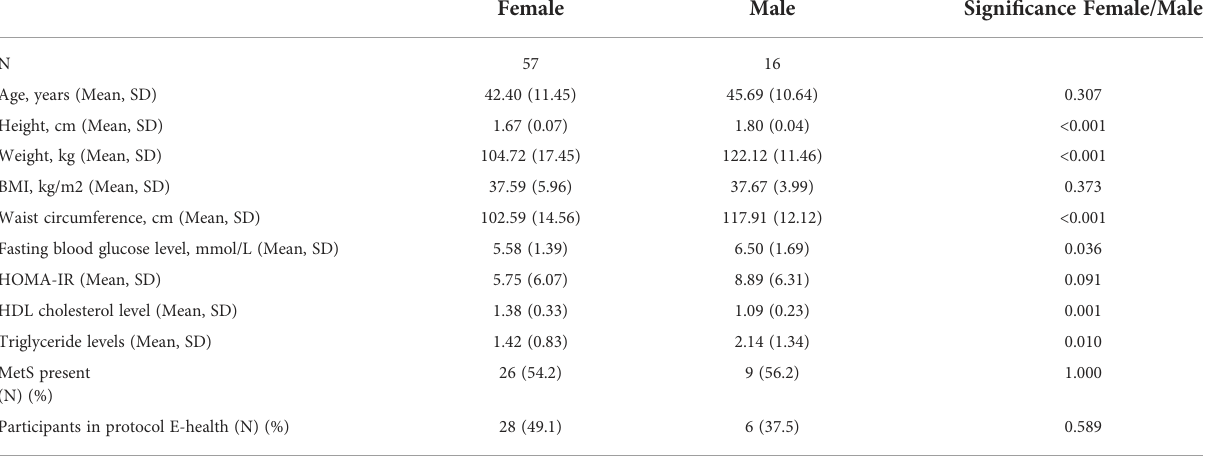
TABLE 1 Baseline characteristics in patients with